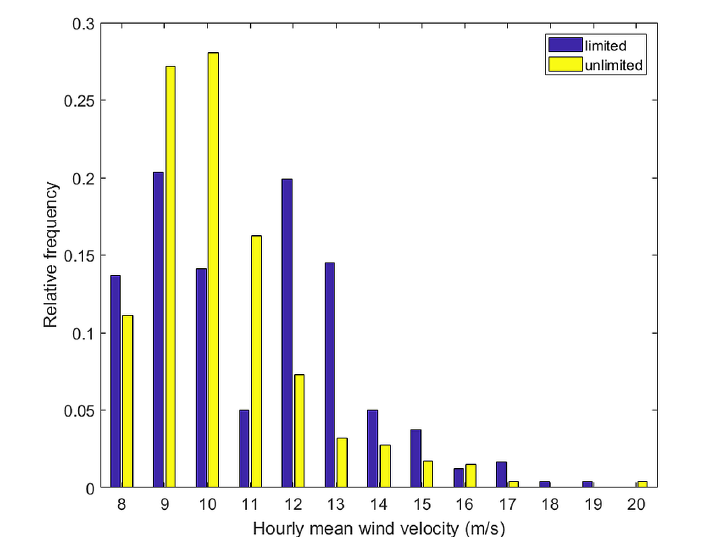
Figure 6. Relative frequency of the wind velocity for limited and unlimited events. The mean wind velocity for unlimited events is 10.3 m/s (standard deviation of 1.9 m/s) and 11.1 m/s (standard deviation of 2.3 m/s) limited transport events.